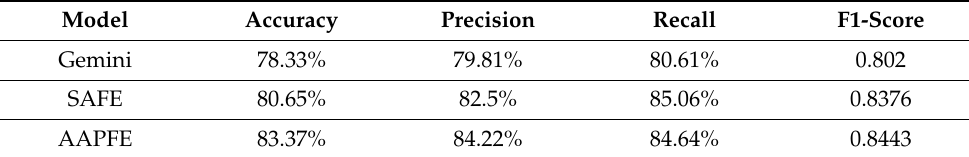
Table 7. Comparison of different models applied in malware